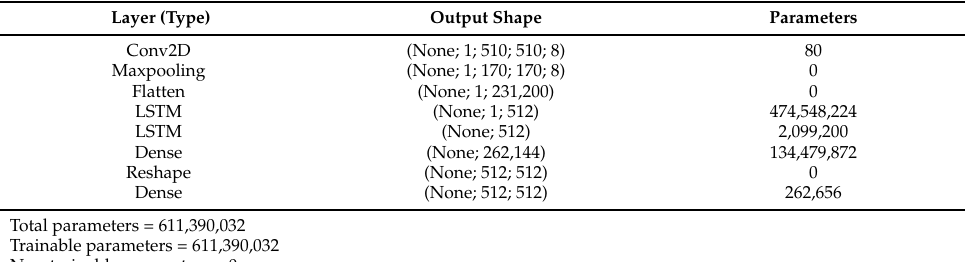
Table 9. Description of the CNN-LSTM network layers.